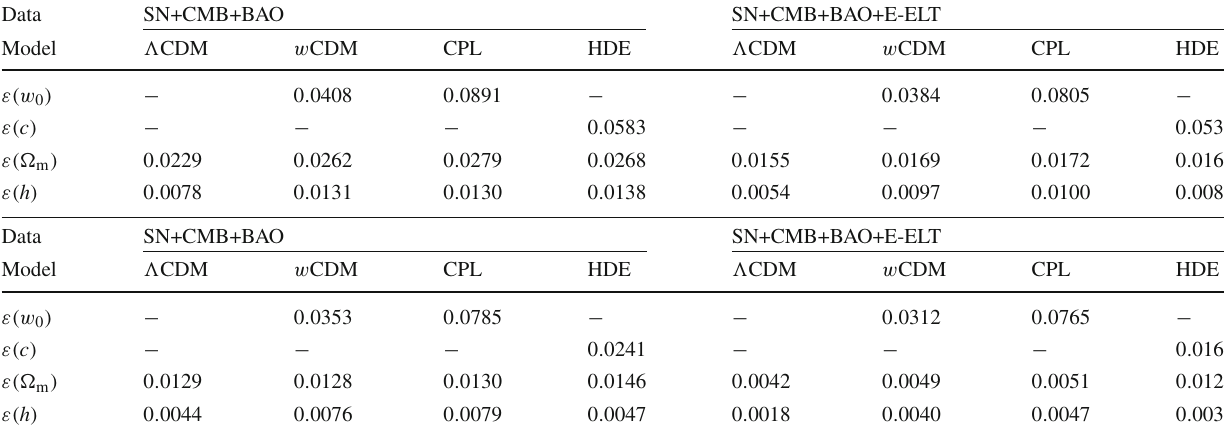
Table 5 Constraint precisions of parameters in (cid:2) CDM, w CDM, CPL, and HDE models using SN+CMB+BAO,